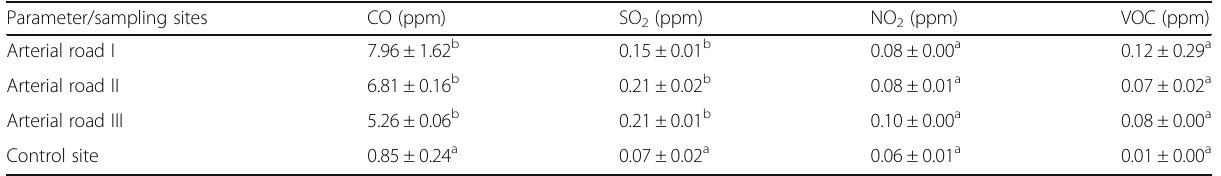
Table 3 Ambient air quality of Kumasi Metropolis during the study period Parameter/sampling sites